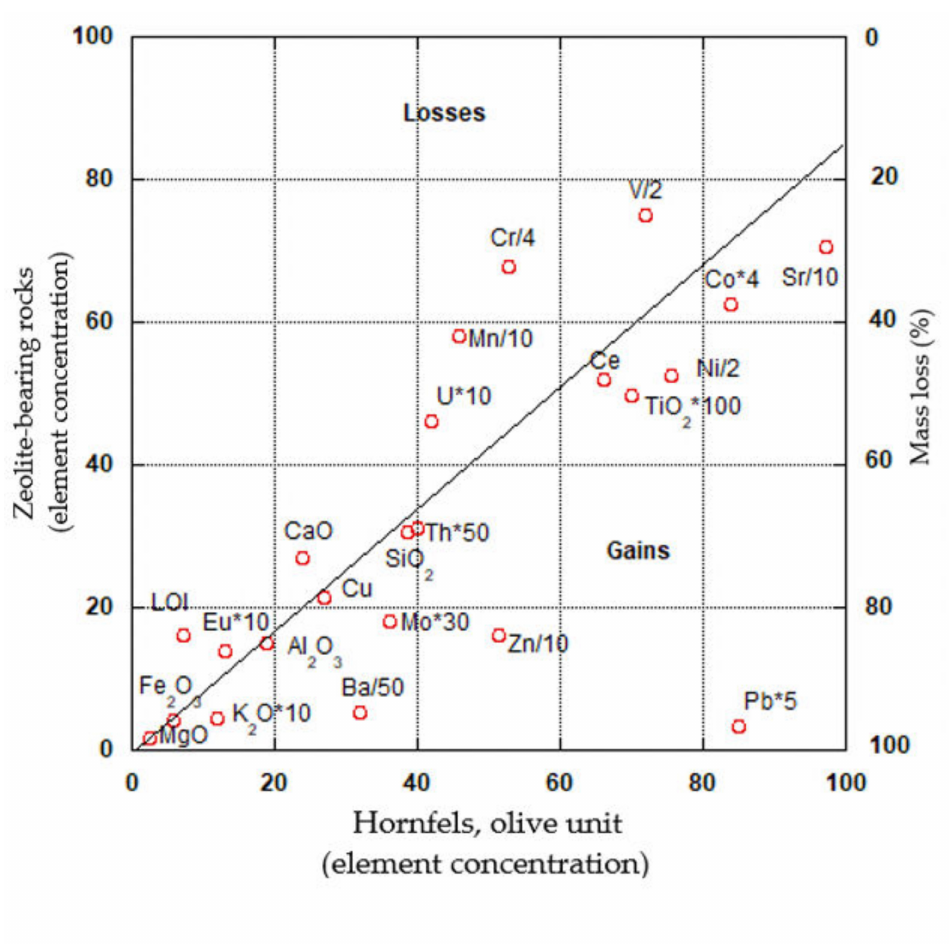
Figure 3. Isocon diagram of the zeolite-bearing rock vs. hornfels of the olive